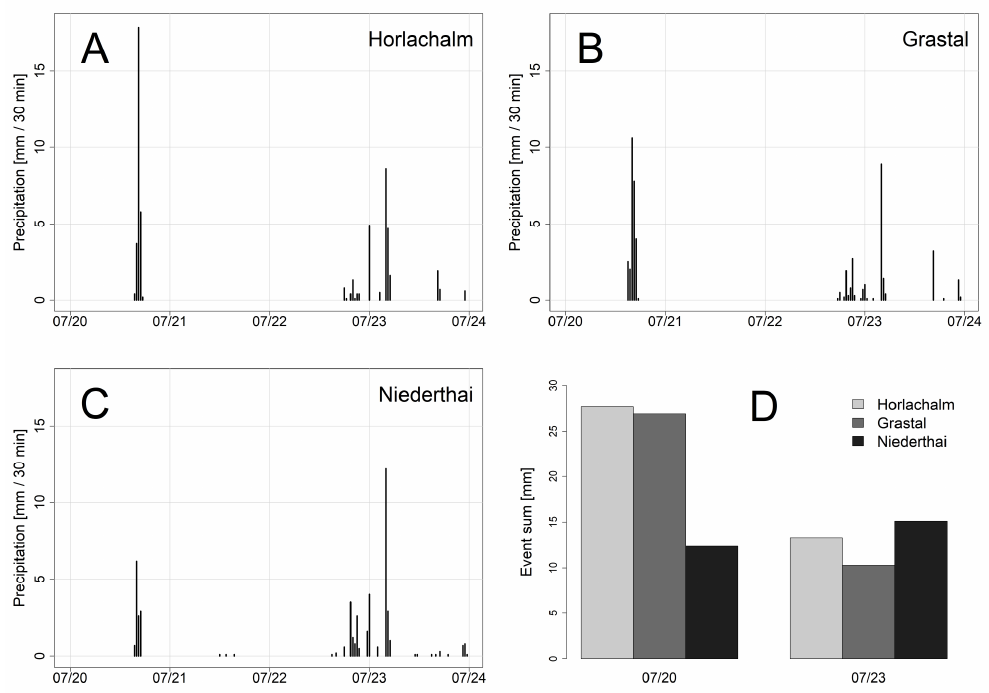
Figure 5. Precipitation intensities recorded by the meteorological stations Horlachalm ( A ), Grastal ( B ) and Niederthai ( C ). The barplots on the bottom right ( D ) display the total precipitation sums of the two events on 20 July (4 p.m. to 6 p.m.) and on 23 July (4 a.m. to 5 a.m.).